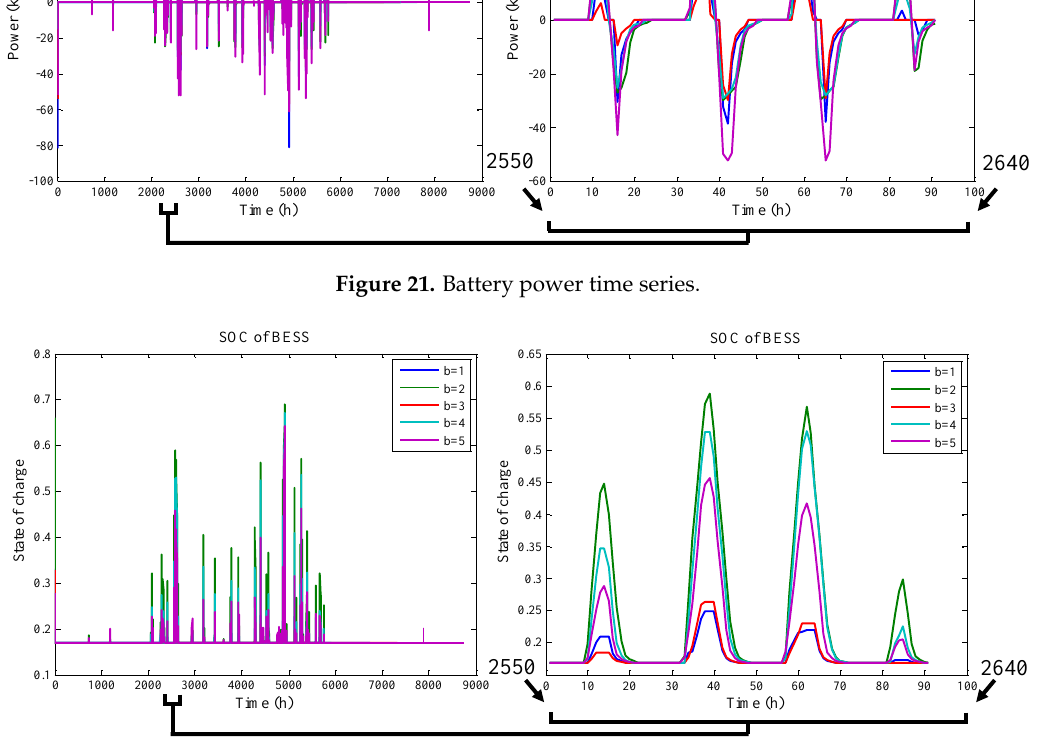
Figure 22. SOC time series.